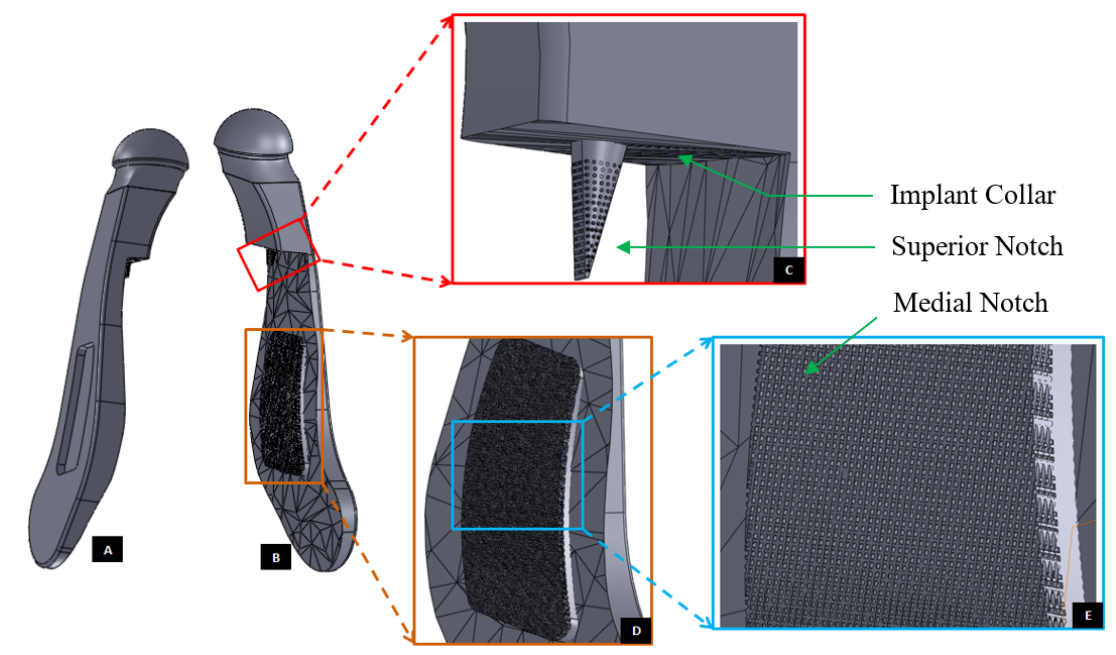
Figure 11. Modification of the custom-designed condylar/ramus component, shown in Figure 9, to include a novel feature; perforated notches protruding into host bone at implantation. ( A ) Shows a grove in the flat lateral surface of the condylar implant. The opposite side of this grove, as shown in ( B ), protrudes out of the medial surface as a notch with perforations. The enlarged views of medial notch and its perforations are shown in ( D , E ). The device also has pointed and perforated notch protruding from inferior surface of the implant’s collar/neck. Perforated surfaces of these notches are designed to permit bone in-growth into the prosthesis after implantation to provide added sta- bility. Dimensions of these notches can be customized to fit the size and shape of patient’s native bone. Protrudes out of the medial surface as a notch with perforations ( C ).